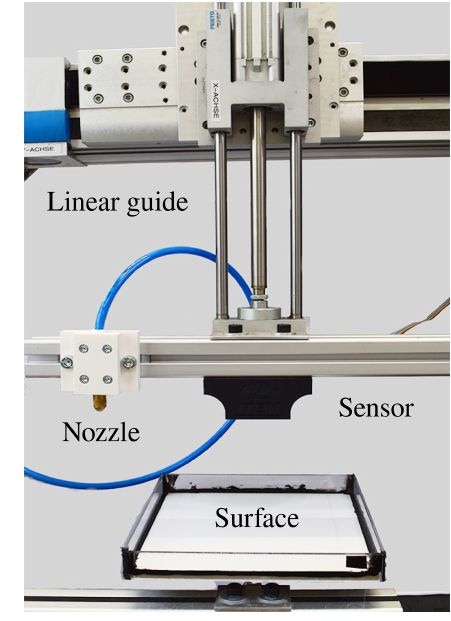
Figure 5. Test bench for generating defined water film heights in 1mm steps.